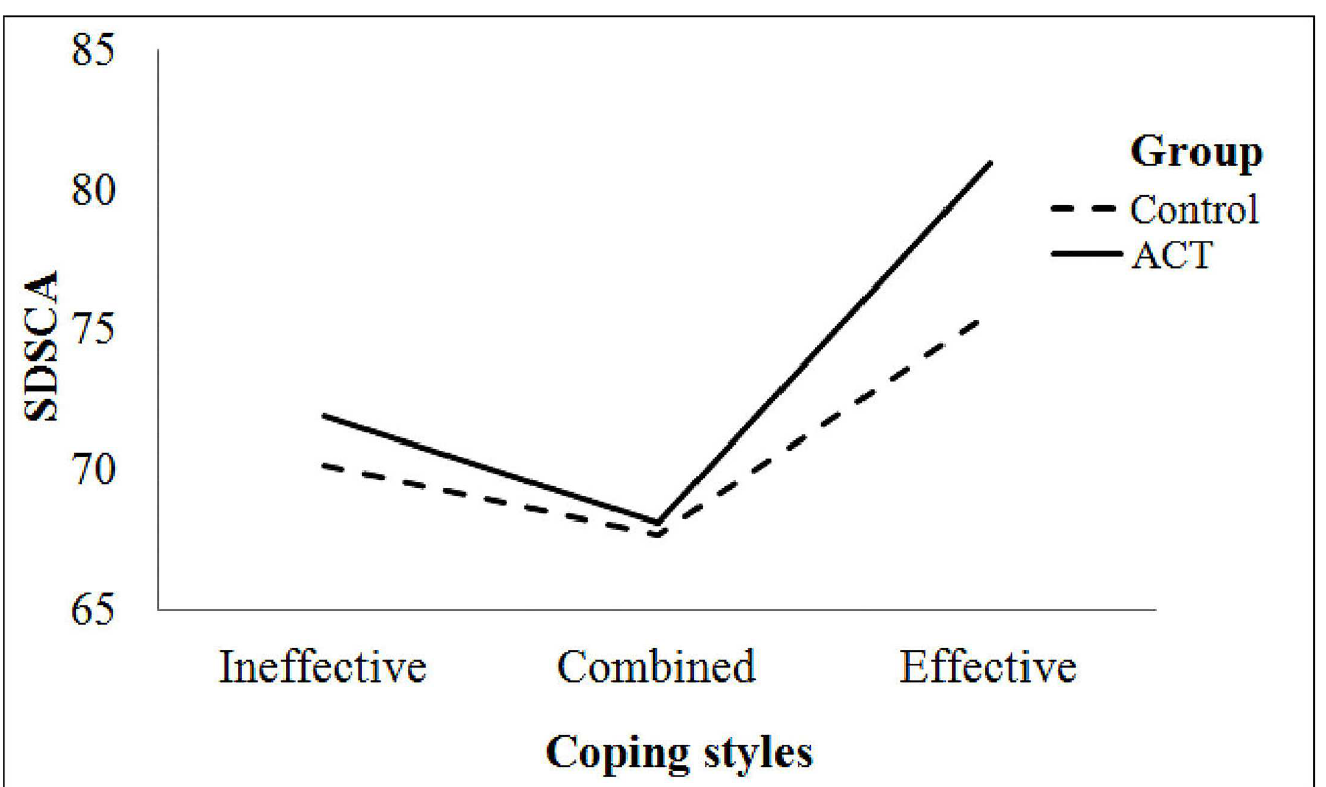
Fig 2. Moderator effectsof coping styles on the relationship between acceptanceand commitment therapy and self-careactivates.